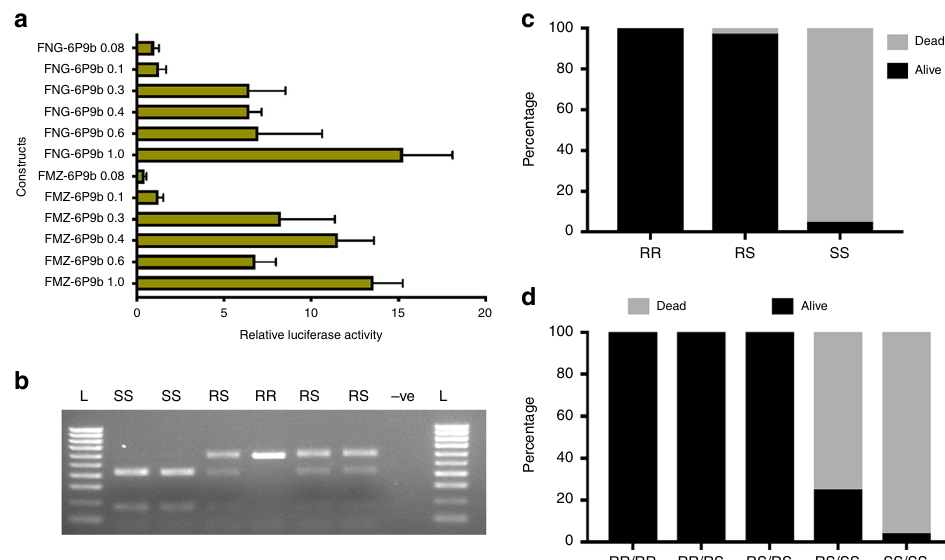
Fig. 3 DNA-based diagnostic assay for CYP6P9b-mediated metabolic resistance to pyrethroids. a Comparative luciferase assay between promoter fragment from the highly resistant FUMOZ and highly susceptible (FANG) lab strains with progressive serial deletions of CYP6P9b 5 ′ fl anking region to detect the causative variants. Bars represent the mean ± S.D. of four independent transfections of three replicates ( n = 6). b Agarose gel of PCR-RFLP with Nmu Cl of CYP6P9b showing the RR, RS, and SS genotypes. c Distribution of the CYP6P9b genotypes between susceptible and resistant mosquitoes showing a very strong correlation between CYP6P9b and resistance phenotype. d Distribution of the combined genotypes of both CYP6P9a and CYP6P9b showing that both genotypes combined to increase the pyrethroid resistance. Source data are provided as a Source Data fi